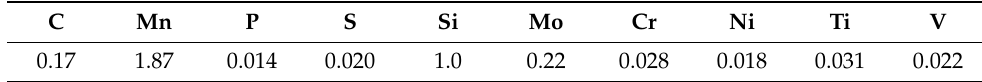
Table 1. Chemical composition of analyzed steel